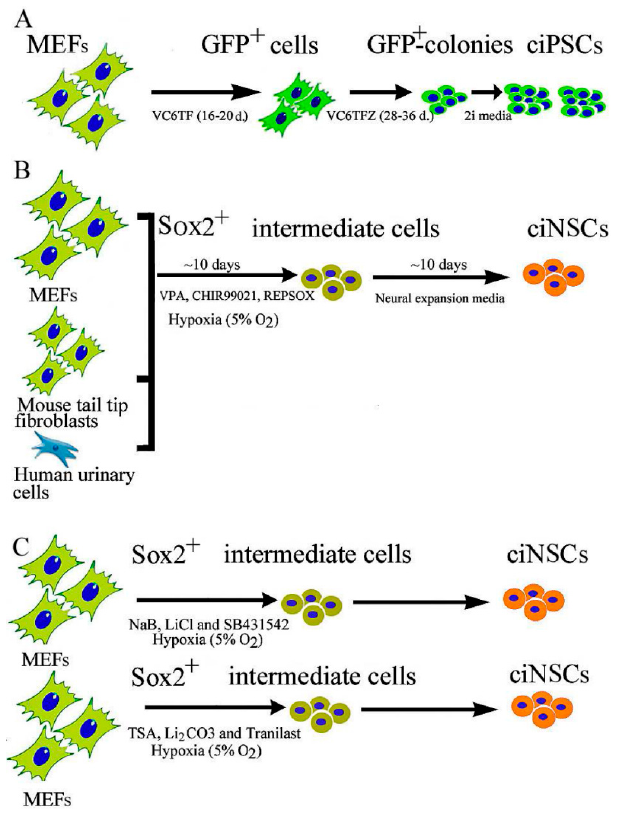
Figure 1. Chemically induced reprogramming of ciPSCs and ciNSCs. ( A ) A schematic diagram showing direct iPSC reprogramming from MEF using the small-molecule cocktail, VC6TF (VPA, CHIR99021, E-616542, Tranylcypromine, Forskolin), and VC6TFZ (VPA, CHIR99021, E-616542, Tranylcypromine, Forskolin and DZNep) followed by application of two MEK and GSK3- β inhibitors, also known as “2i”, to finalize chemical reprogramming. Using a doxycycline (DOX)-inducible GFP-Oct4 expression screening system, ectopic GFP-Oct4 expression was induced during the first round, followed by DOX withdrawal and small molecule treatment. Epigenetic modulators, particularly 3-deazaneplanocin A (DZNep), an S-adenosylhomocysteine hydrolase inhibitor, were later added along with MEK and GSK3- β inhibitors (2i), to achieve complete reprogramming; ( B ) The scheme of direct ciNSC reprogramming from MEFs, mouse tail fibroblasts, and human urinary cells using the small-molecule cocktail VCR (VPA, CHIR99021, and Repsox) and physiological hypoxia; ( C ) A schematic diagram showing direct ciNSC reprogramming from MEF using alternative cocktails NLS (sodium butyrate (NaB), Lithium chloride (LiCl) and SB431542) and TLT (Trichostatin A (TSA), Lithium chloride (Li2CO3) and Tranilast) and physiological hypoxia (5% O 2 ).